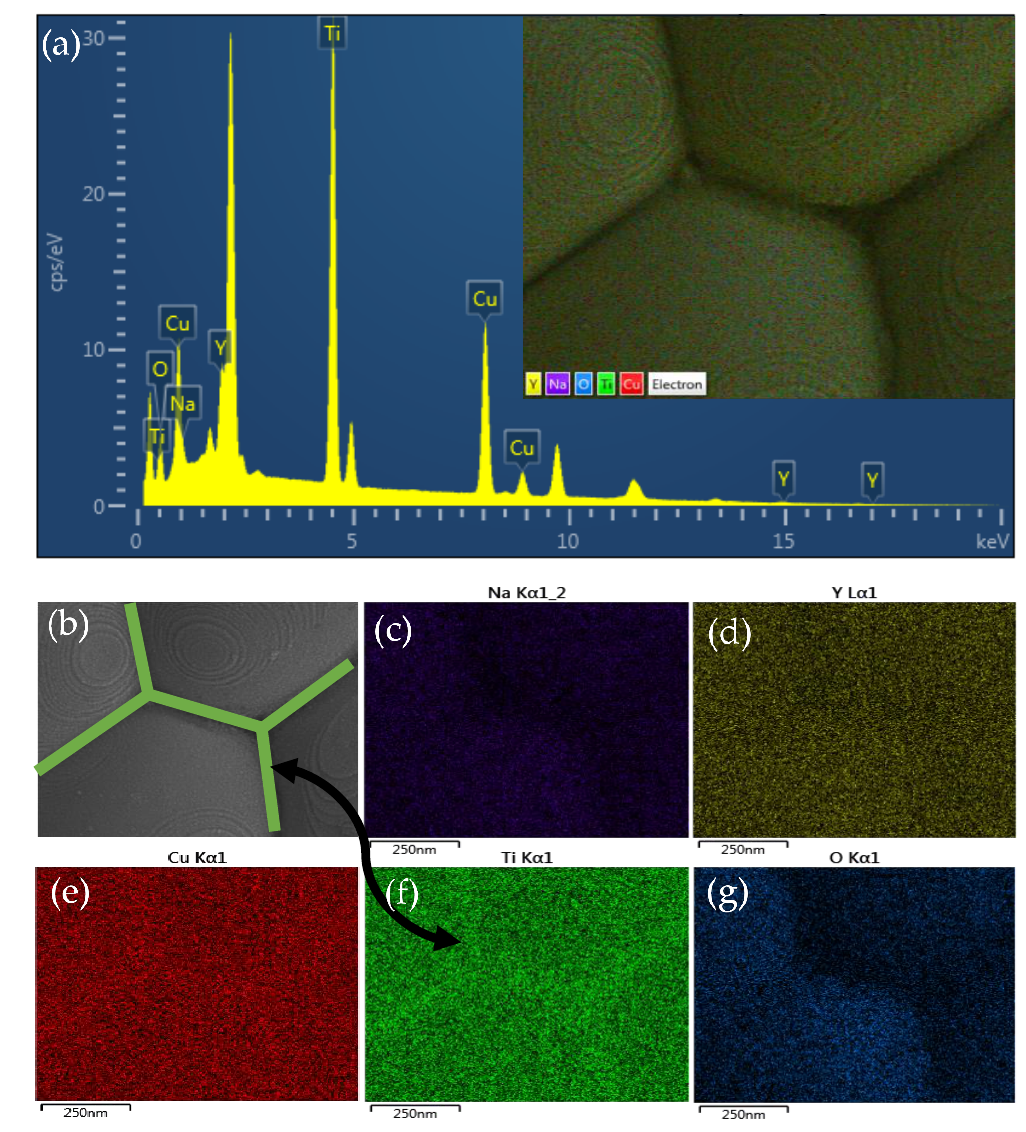
Figure 6. ( a ) EDS spectrum of NYCTO + xTiO 2 ceramic with x = 0.1; inset shows EDS testing area. ( b ) SEM image and corresponding SEM — EDS mapping images of ( c ) Na, ( d ) Y, ( e ) Cu, ( f ) Ti and ( g ) O for NYCTO + xTiO 2 ceramic with x = 0.1.